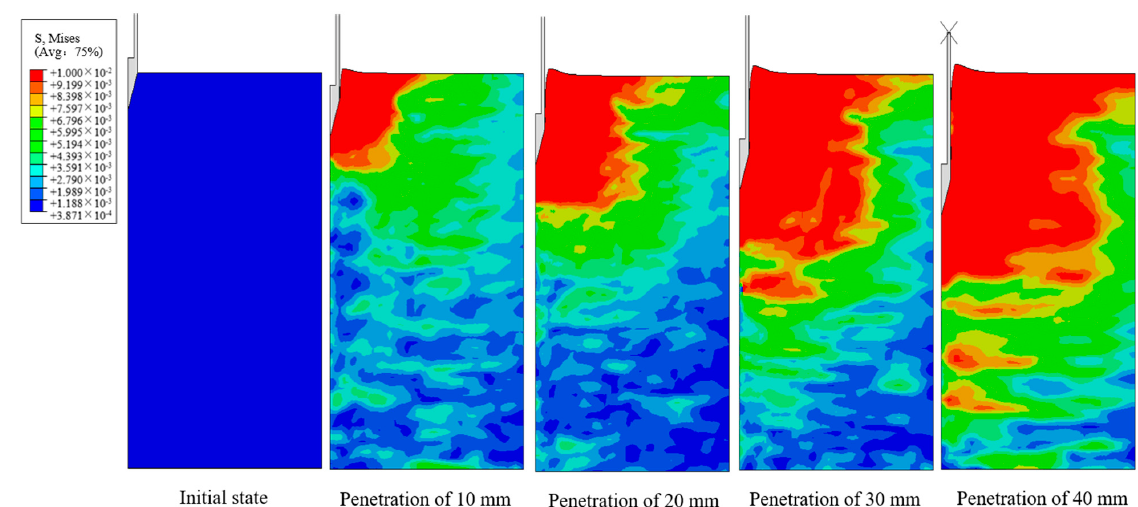
Figure 8. Analysis diagram of the probe penetration process.